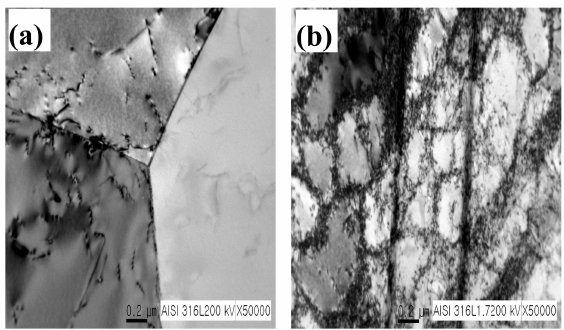
Figure 4. Transmission electron micrographs showing dislocation substructures in the specimens after low-cycle fatigue failure: ( a ) as-received specimen and ( b ) 1.7% ( N f =